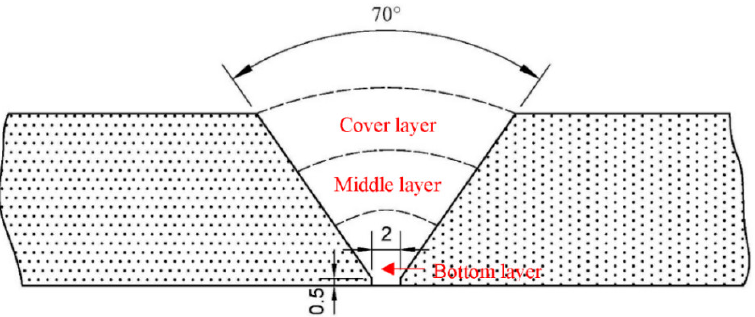
Figure 1. Shape and size of 7N01-T4 aluminum alloy groove .